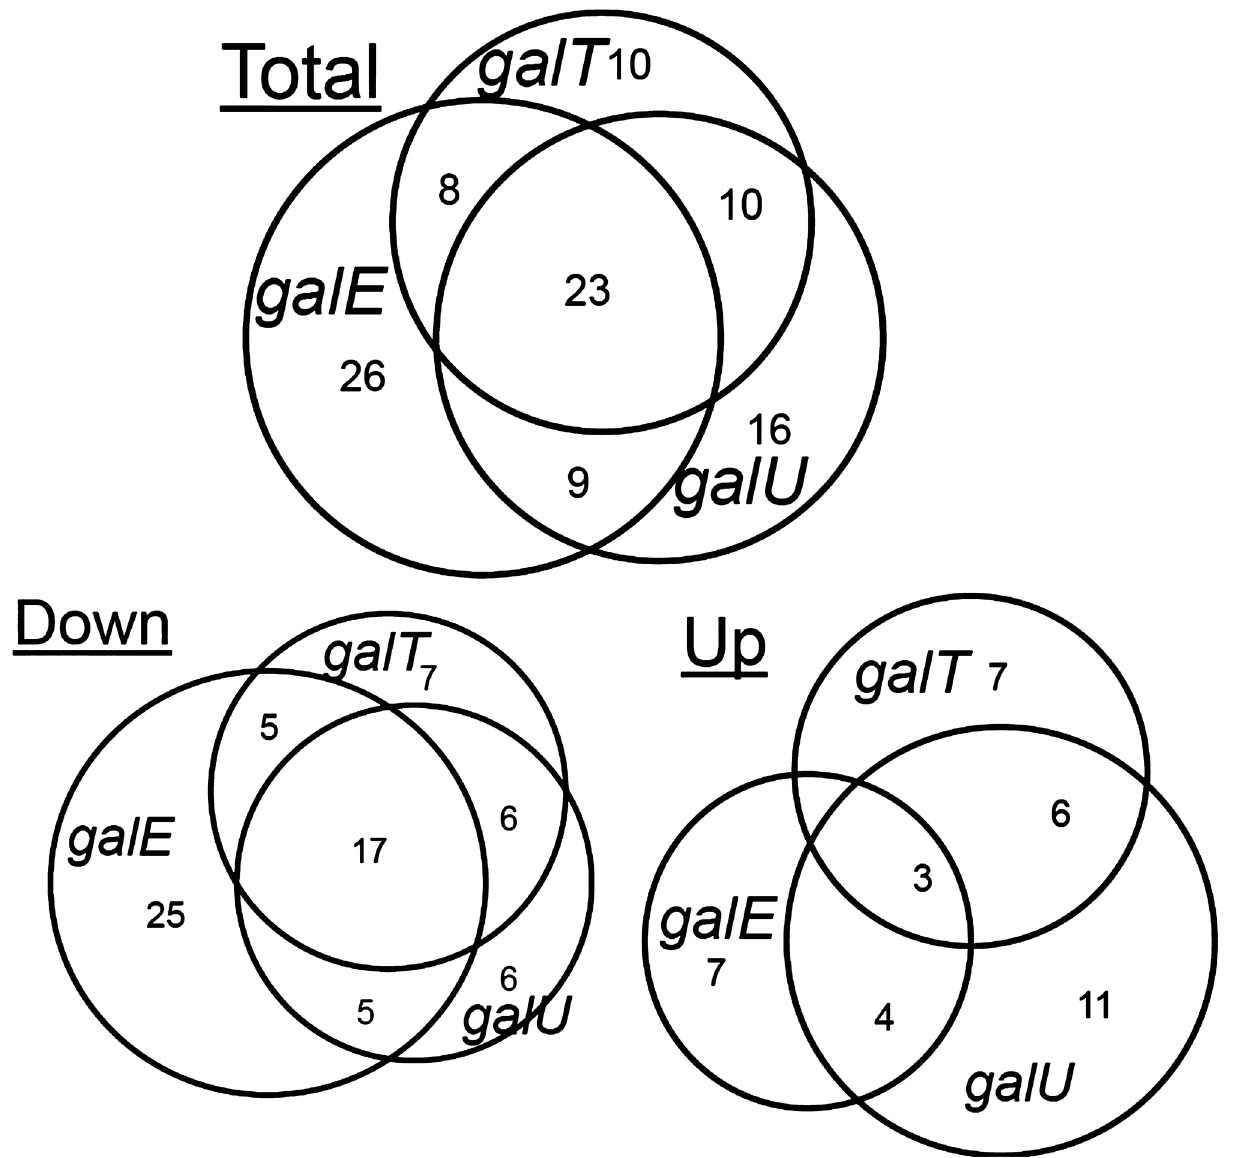
Figure 2. Significantly altered metabolites in different E. coli strains grown in galactose supplemented media. Top venn- diagrams show all the metabolites that were altered by galactose supplementation to three mutant strains. Numbers in parenthesis are total metabolites significantly affected by gal mutations. Bottom two venn-diagrams show the separated significantly increased and decreased metabolites following the galactose supplementation. Welch’s two sample T-test were calculated to identify the significantly altered metabolites at p -value less than 0.05